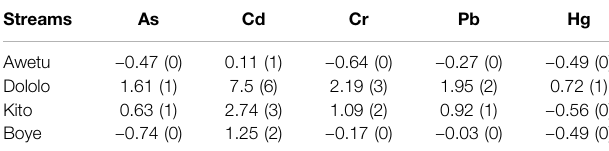
TABLE 4 | I geo values for heavy metals in surface sediments of Awetu watershed